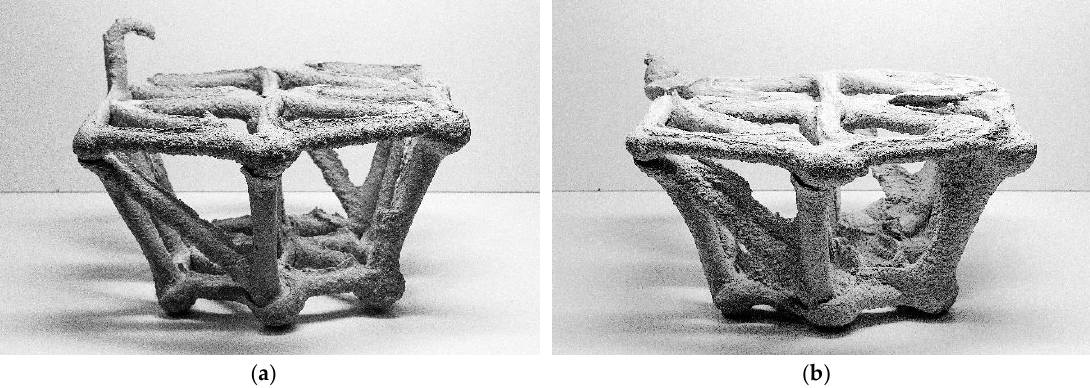
Figure 7. Objects printed in two different support mediums: ( a ) printed in a gel-sand suspension; ( b ) printed in a limestone powder quartz sand suspension.